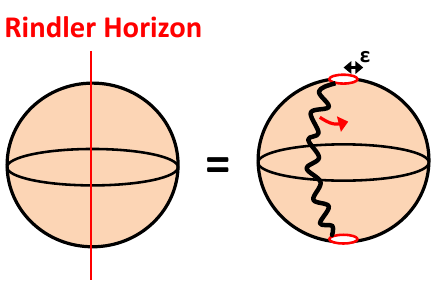
Figure 11 . The sphere partition function of closed string world-sheet with north and south pole pinned at the Rindler horizon (left) can be equivalently described by the one-loop partition function of open string which connects the two poles